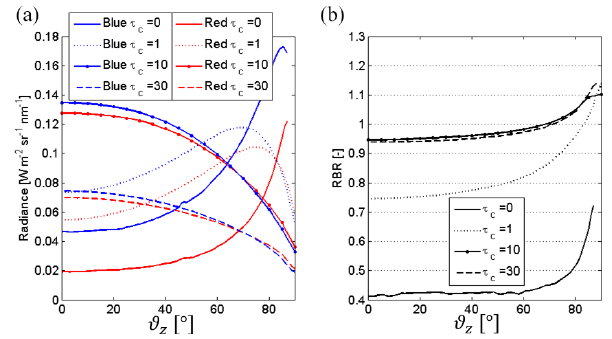
Figure 7. (a) Red and blue channel radiances and (b) RBR over various ϑ z at constant ϑ s = 60 ◦ and θ 0 = 60 ◦ . Pixels used for Fig. 7 are highlighted as a red line in Fig.